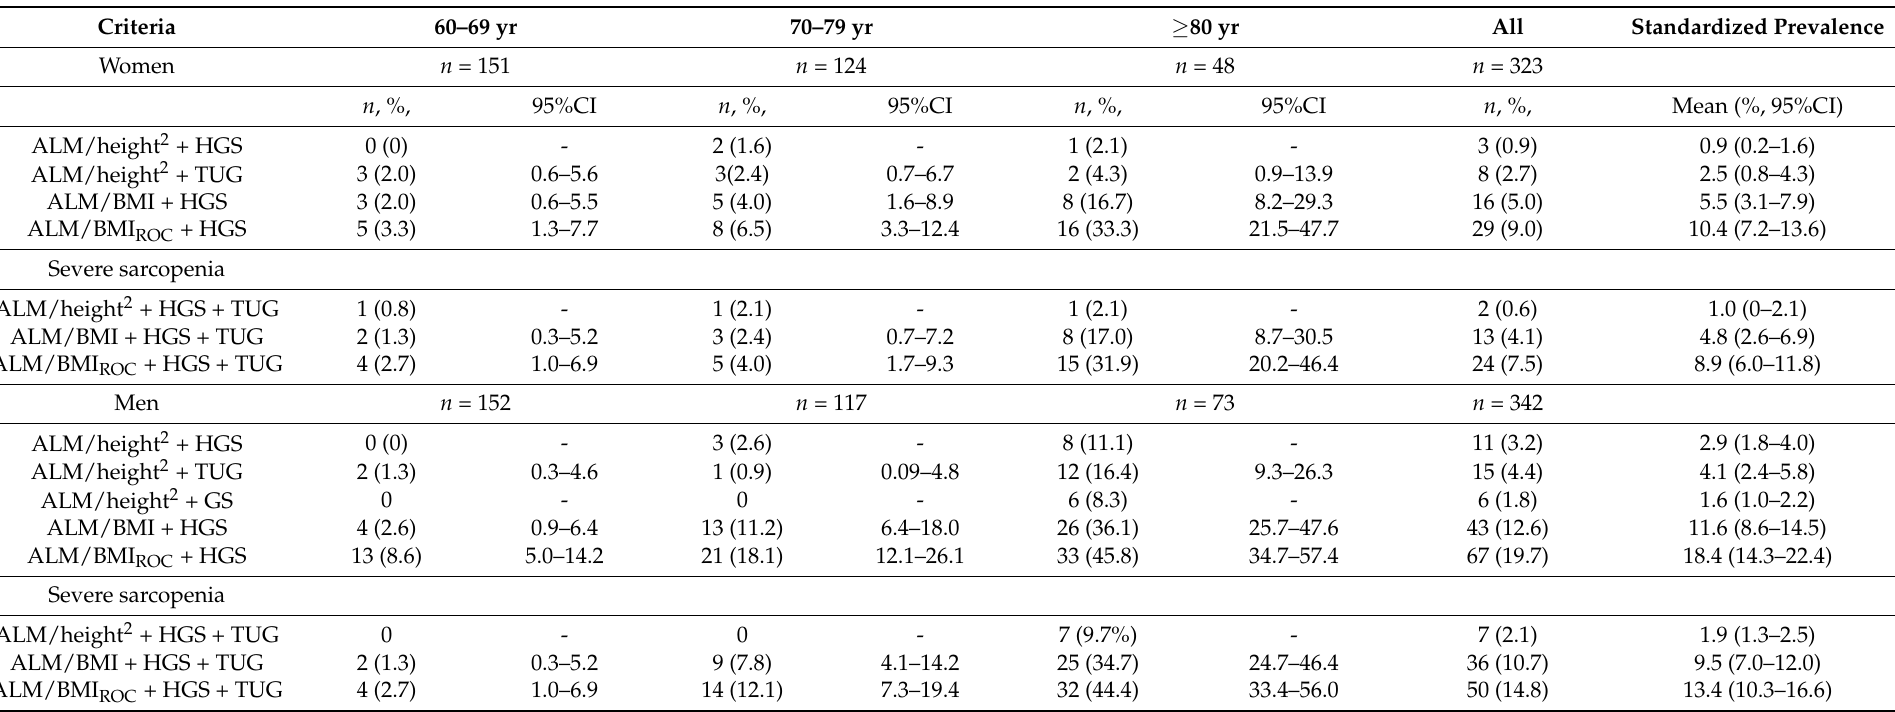
Table 3. Age- and sex-specific prevalence estimates of sarcopenia according to different assessment